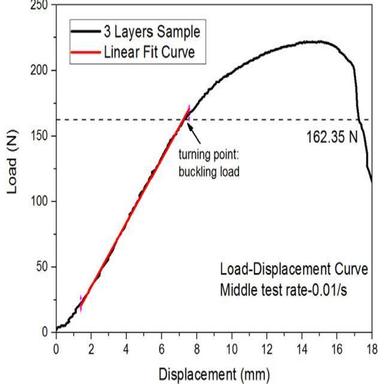
Load-displacement curve of an IM7/8552 specimen of 3 plies thickness, 8 mm wide shear band tested at 0.01/s. (For interpretation of the references to colour in this figure legend, the reader is referred to the web version of this article.)